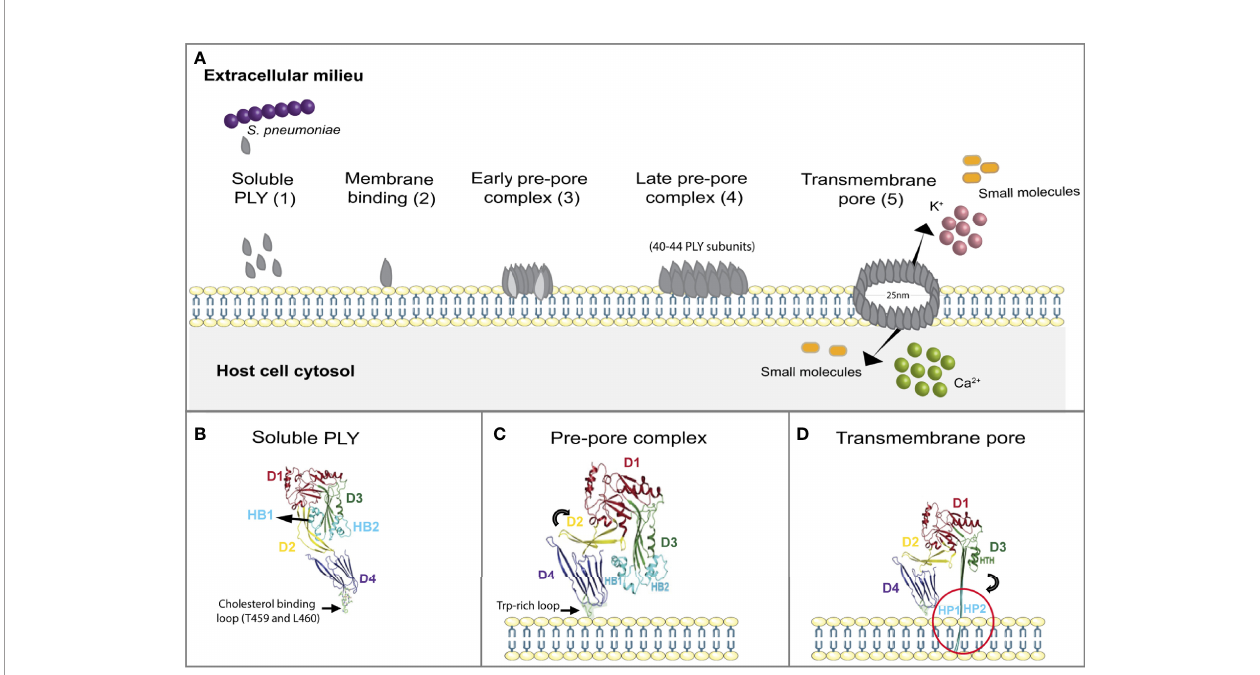
FIGURE 2 | Mechanisms of PLY-mediated host plasma membrane permeabilization and conformational changes associated to pore formation. (A) PLY pore-formation is a multi-step process. PLY is released by S. pneumoniae as a water-soluble monomer (1) which speci fi cally bind to cholesterol residues on the host cell plasma membrane (2). PLY monomers oligomerize by interacting with each other to form the early pre pore complex (3), which protrudes into the membrane surface establishing the late pre-pore (4). Finally, PLY inserts hairpins HP1 and HP2 across the membrane forming an open transmembrane channel, which allows the uncontrolled in fl ux and ef fl ux of ions and small molecules (5). (B) Soluble PLY. The 3D crystal structure of PLY monomer as it is released from S. pneumoniae is shown. The 4 major domains, from D1 to D4, as well as Helix Bundles (HB) 1 and 2 and cholesterol binding loop are indicated. The arrow indicates residues T459 and L460 in the D4 Trp-rich loop which are essential for cholesterol recognition. (C) PLY in pre-pore complex. Structure of PLY upon cholesterol binding via the conserved D4 Trp-rich loop. Interaction with cholesterol induces a 90° rotation of D2 (in yellow, indicated by the curved arrow) bringing D1and D3 towards the host plasma membrane. HB1 and HB2 are positioned just above the host membrane. This structural organization is maintained in the pre-pore stage. (D) PLY in the transmembrane pore. The 3D structure of PLY when inserted in the host cell plasma membrane is depicted. HB1 and HB2 refold into 85 Å b -hairpins HP1and HP2 (shown by the curved arrow), which insert (red circle) and cross the hydrophobic membrane to form an open transmembrane pore. Adapted from